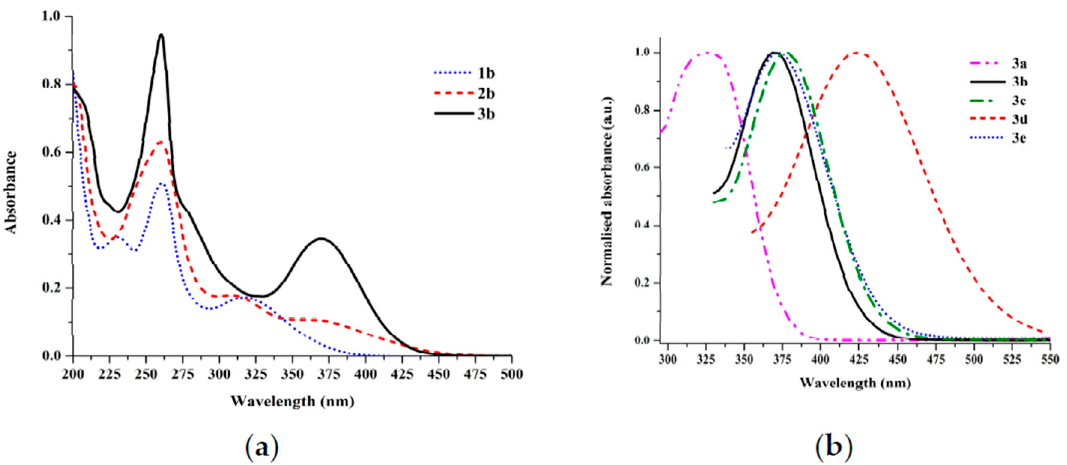
Figure 2. UV Ultraviolet absorption spectra recorded in acetonitrile solution at concentration 10 − 5 M: ( a ) phenyl-TAPTZ 3b , N -(phenothiazine-3-yl)-thiobenzamide 2b , and N -(phenothiazine-3-yl)-benzamide 1b ; ( b ) normalized longest wavelength absorption band for TAPTZ 3a – e (a.u. = arbitrary units). Table 1. Experimental UVultraviolet-vis spectral properties and computational data for TAPTZ derivatives. Cpd